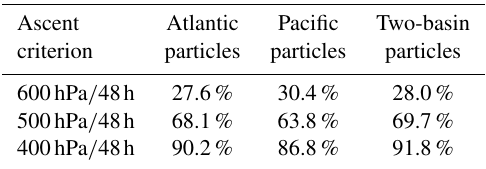
Table 1. The fractions of the 10d tracking moist particles of differ- ent moisture sources which fulfil different ascent